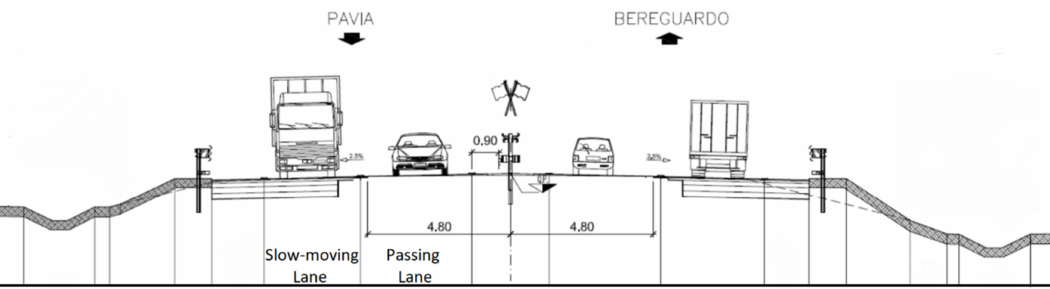
Figure 2. The final cross section of the